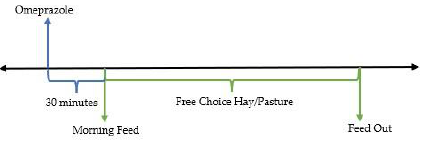
Figure 4. Proposed timing of omeprazole administration and feeding.